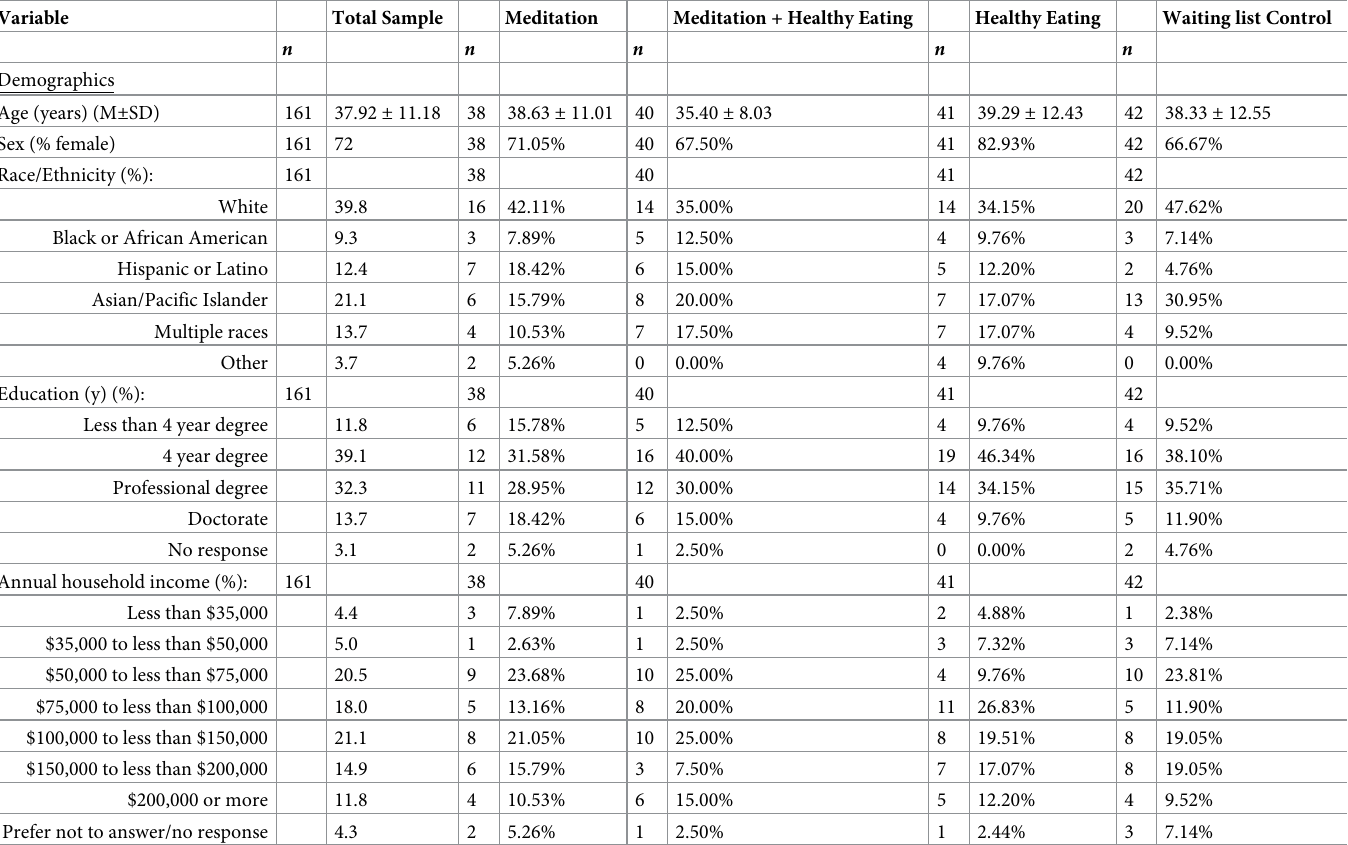
Table 1. Baseline